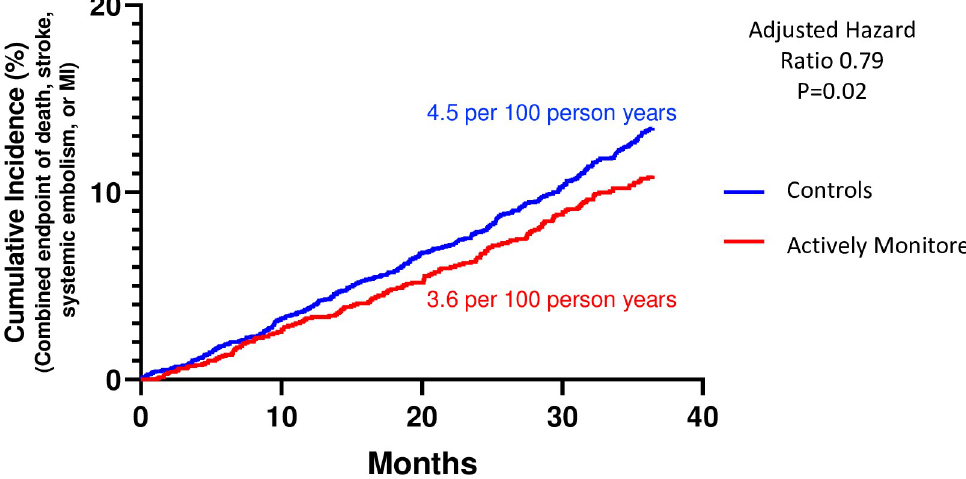
Fig 3. Primary endpoint. Cumulative incidence of the combined primary endpoint of death, stroke, systemic emboli or myocardial infarction in actively monitored and observational control cohorts over the 3 years following initiation of